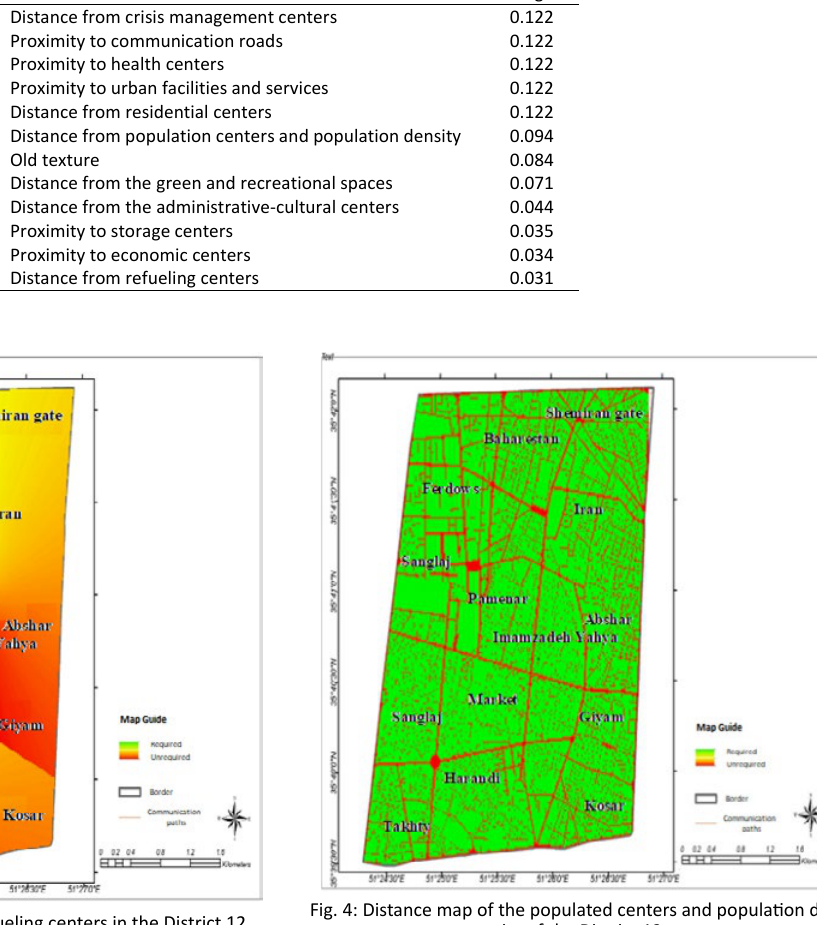
Fig. 3: Distance map of the refueling centers in the District 12